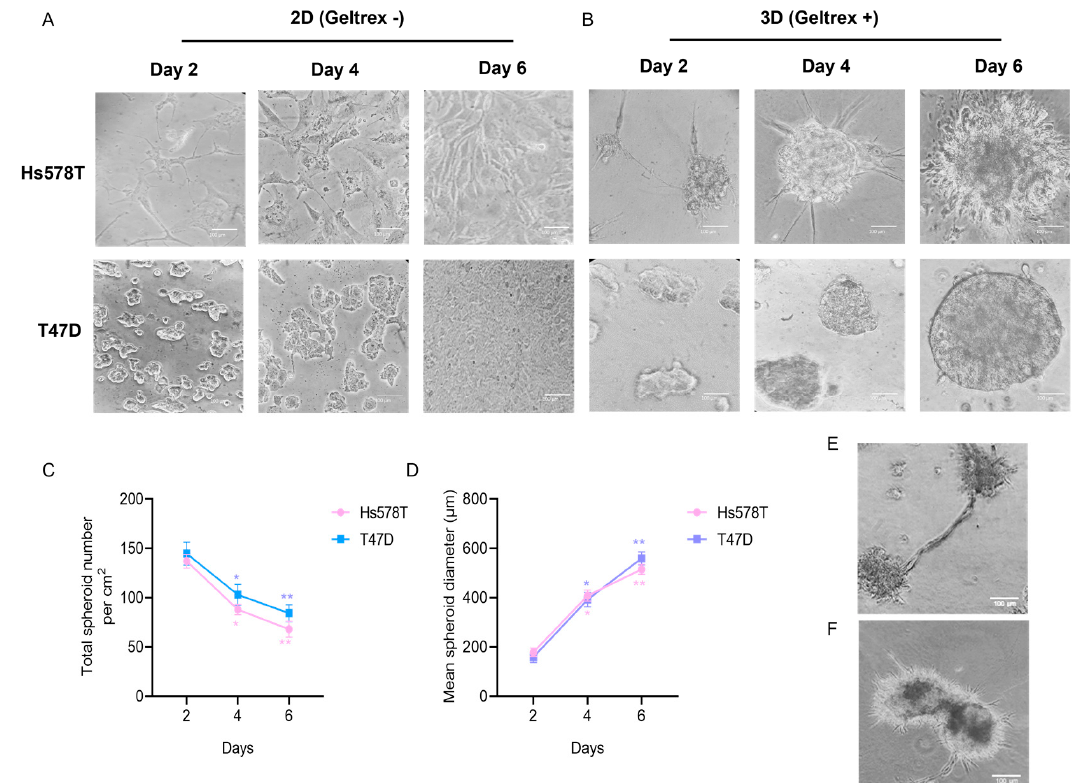
Figure 1. Establishment of 3D organotypic cultures of breast cancer cells. ( A ) Images taken by light microscopy (40×) corresponding to Hs578T and T47D cells cultured in 2D without geltrex for 2, 4, and 6 days. ( B ) Optical microscopy images (40×) of Hs578T and T47D cells cultured in the 3D microenvironment with geltrex reagent for 2, 4, and 6 days. ( C ) Quantification of the total number of spheroids formed in 3D cultures at 4 and 6 days in comparison to day 2, respectively. ( D ) Quantification of the average diameter of spheroids in 3D cultures at days 4 and 6 in comparison to day 2, respectively. ( E , F ) Light microscopy images (40×) showing nanotube-like structures (top panel) and probable fusion (bottom panel) between spheroids of Hs578T cells grown in 3D conditions. Scale bar = 100 μ m. Data are representative of three independent experiments ± SD. * p < 0.05, ** p < 0.01.